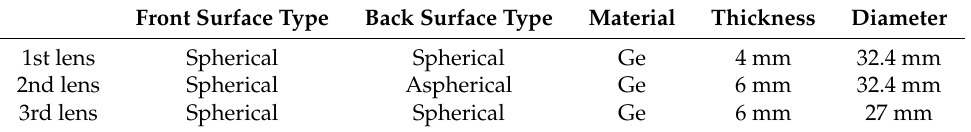
Figure 1. Optical design of the LW camera. The total axial length equals 86.12 mm. The system consists of 3 singlet lenses. The aperture stop is situated between the first two lenses. The circular image on the detector has a radius of 6.528 mm. The different colors correspond to the different fields between 0° and 70°. Table 1. Lens data: surface types, materials, thicknesses and diameters. The 3 lenses are made of